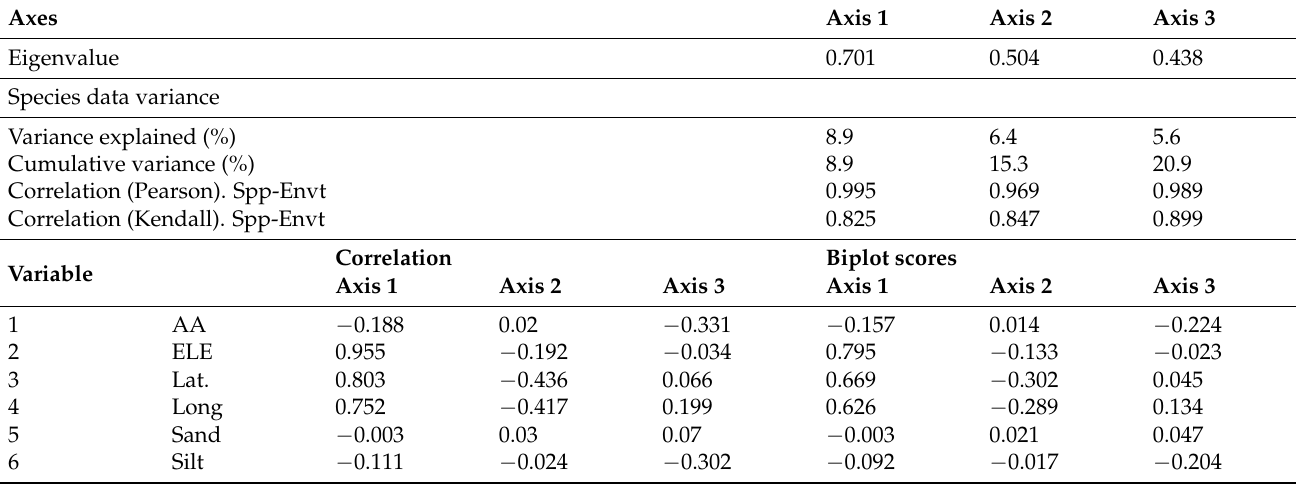
Table 3. Canonical correspondence analysis axes summary, correlation and biplot scores of the environmental variables.